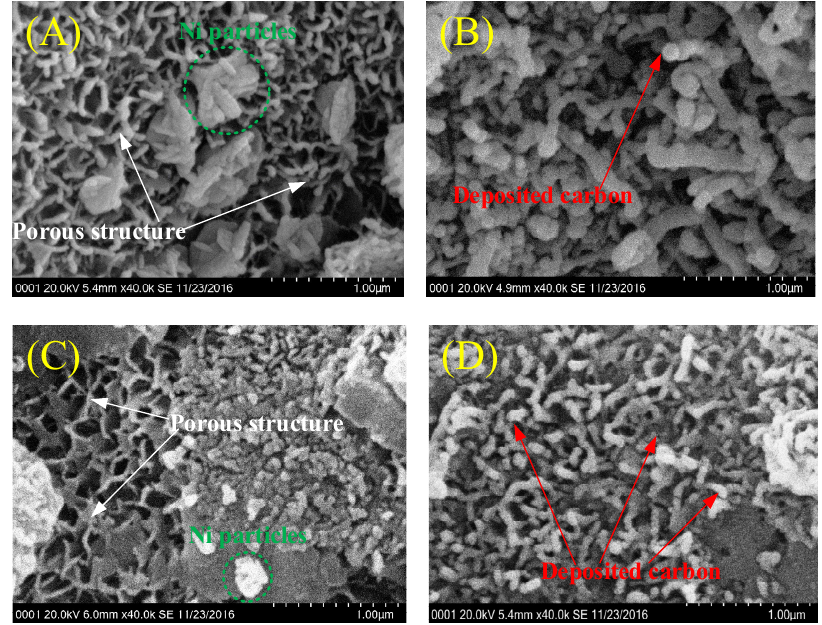
Figure 10. SEM (scanning electron microscope) images of reduced catalysts: ( A ) 15Ni ‐ 3Mn; ( C ) 15Ni ‐ 3Cr; and spent catalysts: ( B ) 15Ni ‐ 3Mn; ( D ) 15Ni ‐